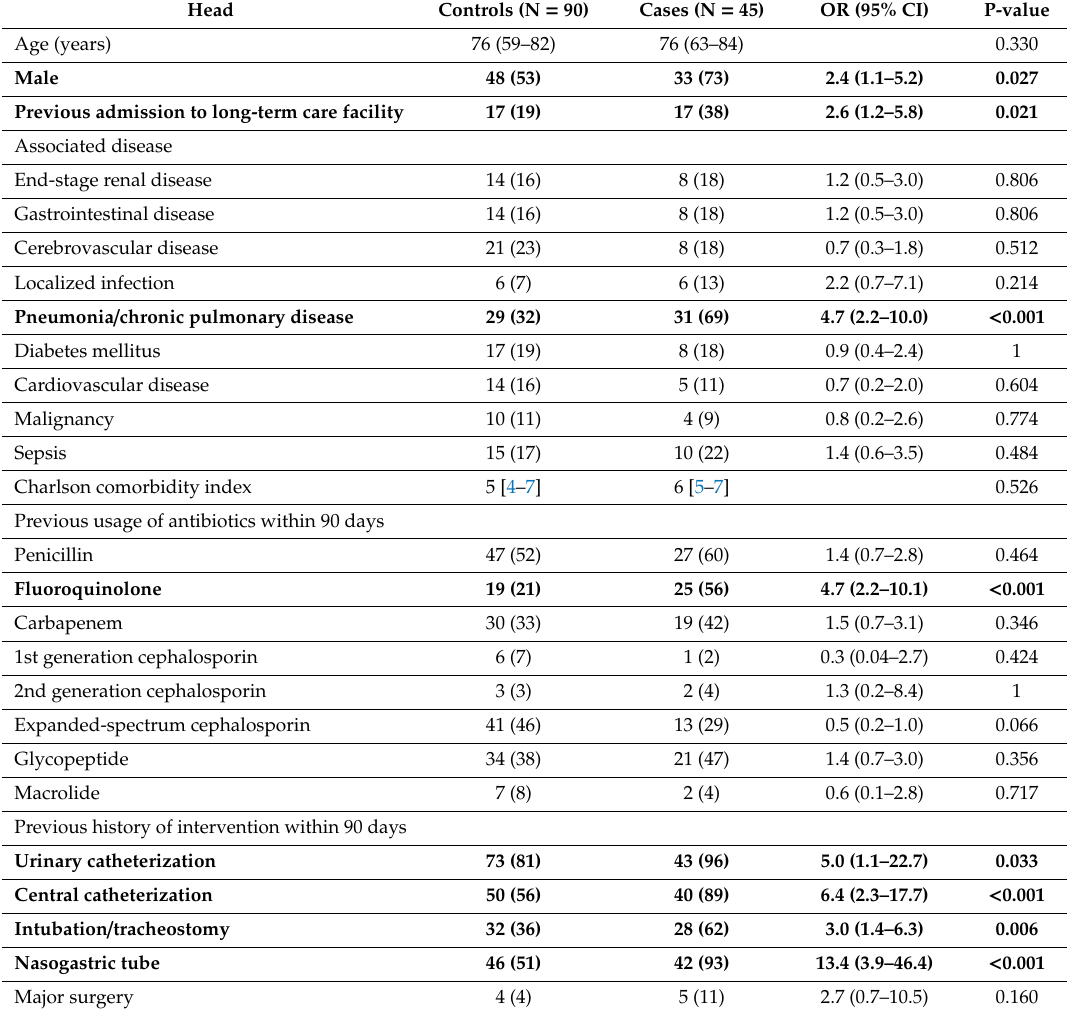
Table 2. Univariate analysis of risk factors for infection or colonization of carbapenemase-producing Enterobacterales in medical intensive care unit using univariate analysis.